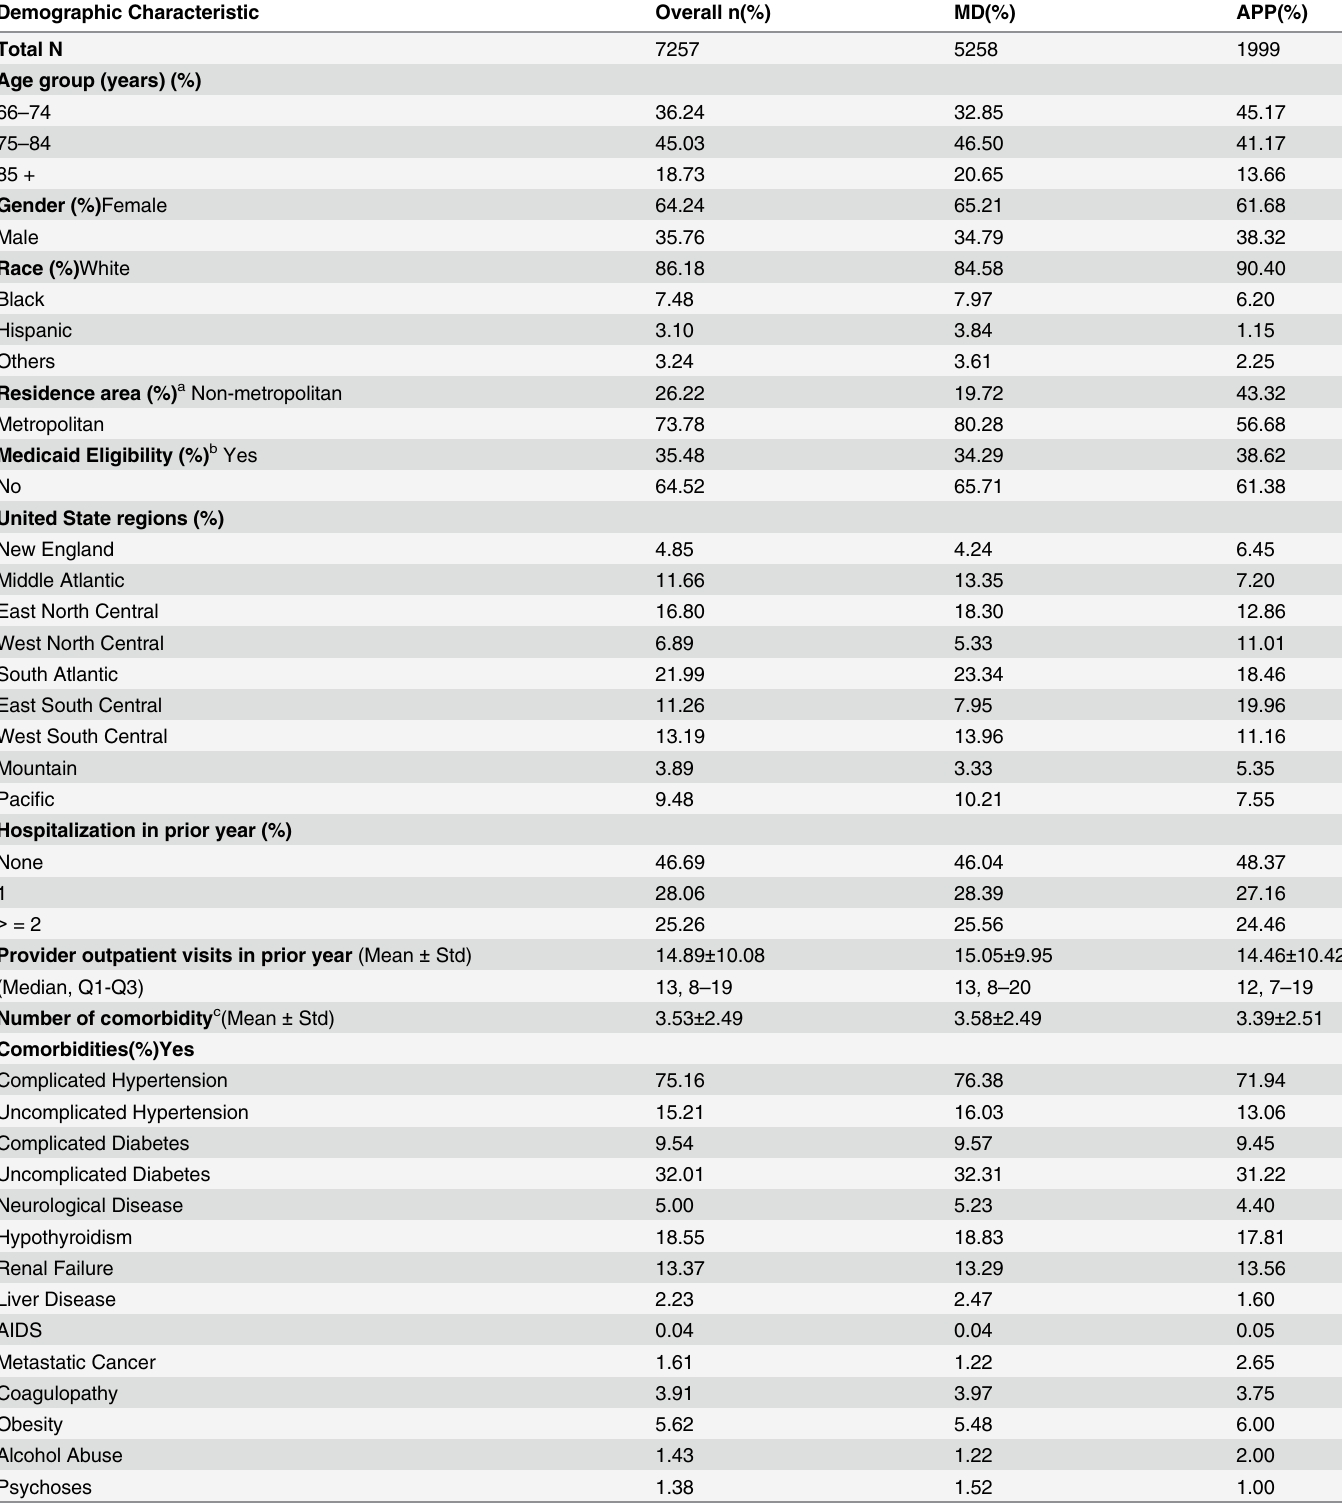
Table 1. Baseline characteristics of COPD patients cared for by an MD or an APP during